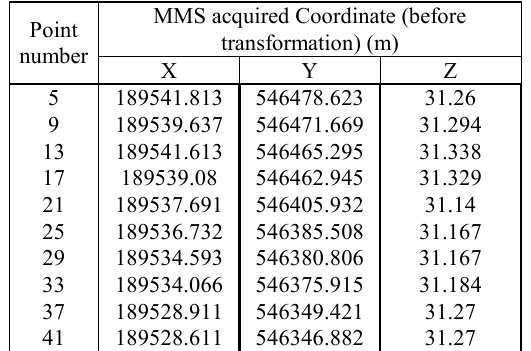
Table 5. Check point coordinates